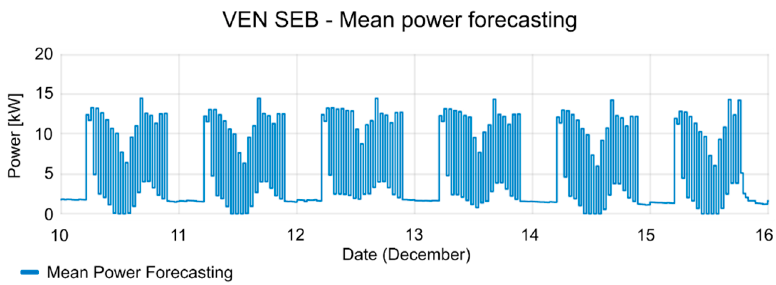
Figure 15. Forecasting of consumption during testing period.